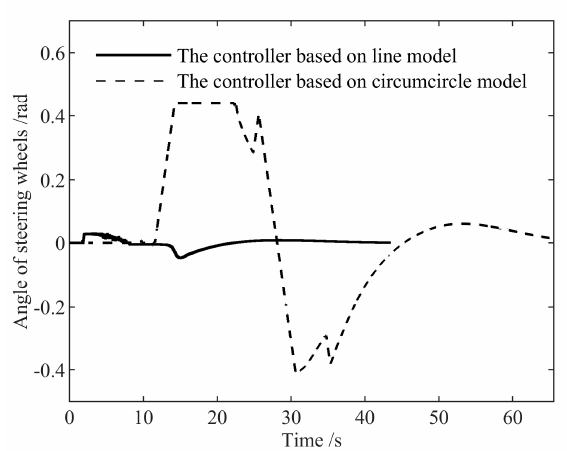
Figure 20. The angles of steering wheels in the second group of simulations.